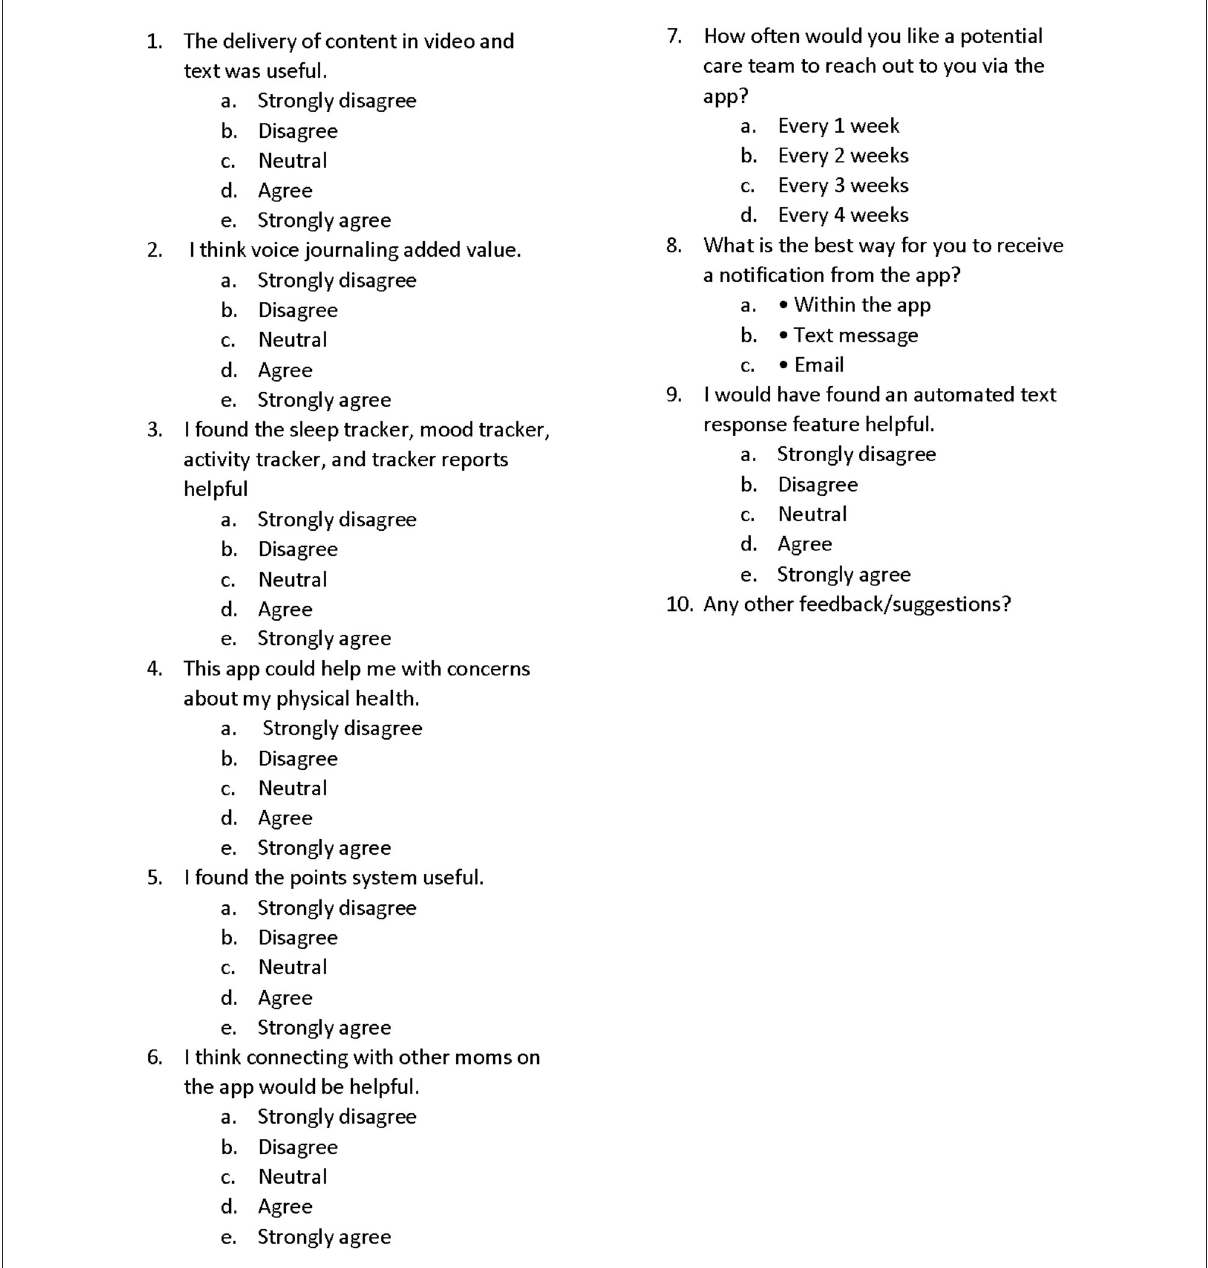
FIGURE4 User experience